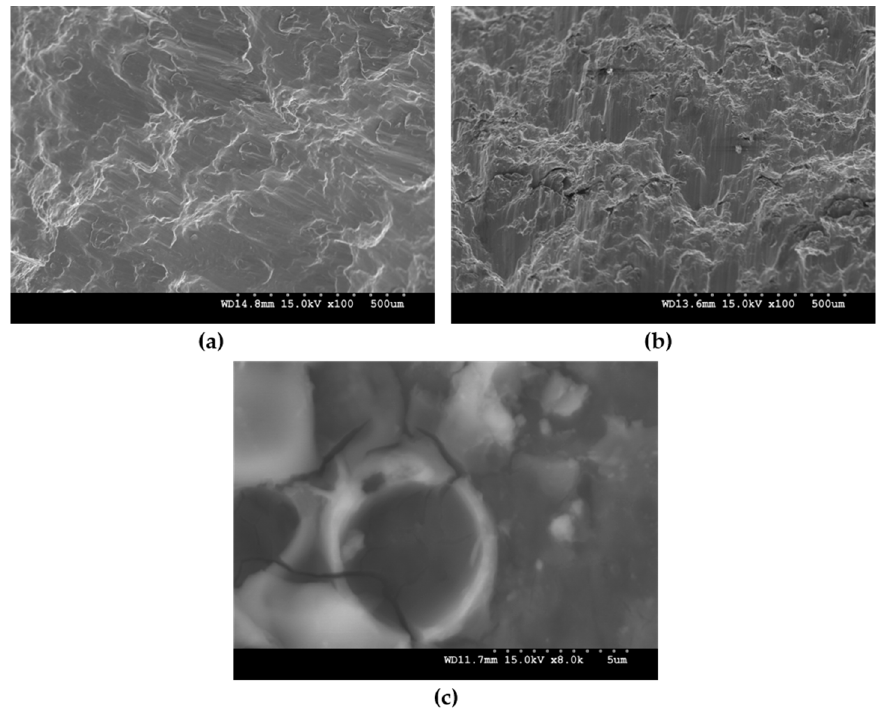
Figure 4. Representative fractographs after compressive loading of: ( a ) Pure Mg, ( b ) Mg-25 and ( c ) crack observed in a glass microballoon (GMB) particle during the plateau region.